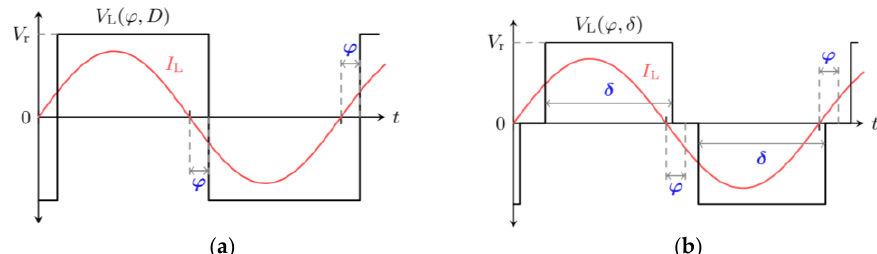
Figure 5. Graphs of voltage V L and current I L delayed by the phase shift φ obtained by varying: ( a ) the buck duty-cycle D and ( b ) the active rectifier duty-cycle δ , where V r is the resulting rectified voltage [18].